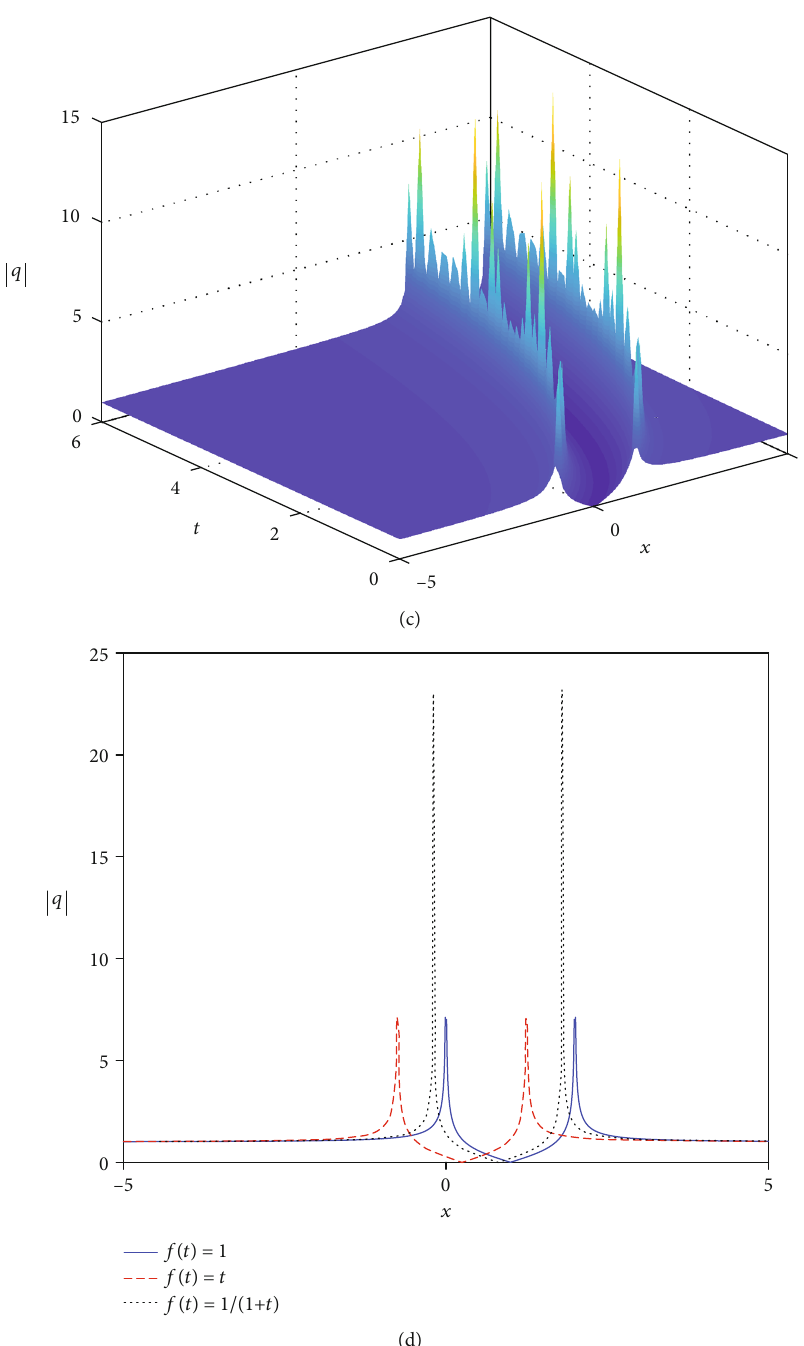
Figure 6: (a – c) The 3D wave shapes of j q j : (a) f ð t Þ = 1 , (b) f ð t Þ = t , and (c) f ð t Þ = 1/ ð 1 + t Þ . (d) The wave propagates along the x